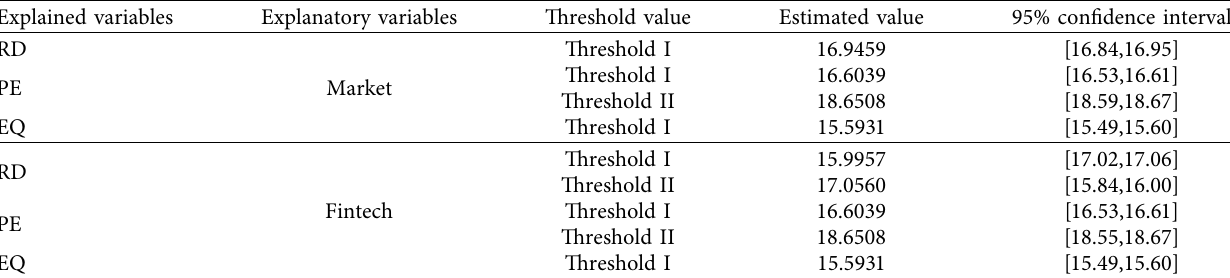
Table 8: Threshold estimates and confidence intervals.